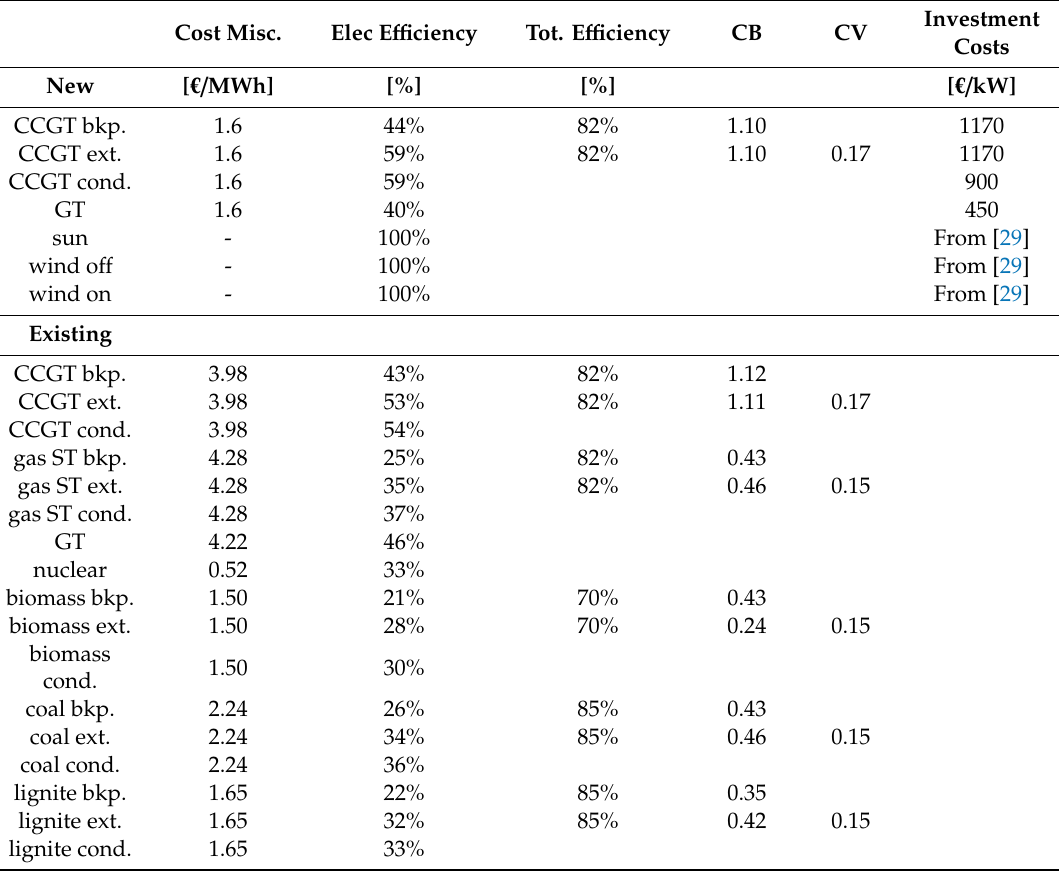
Table 1. Characteristics of new and existing generation